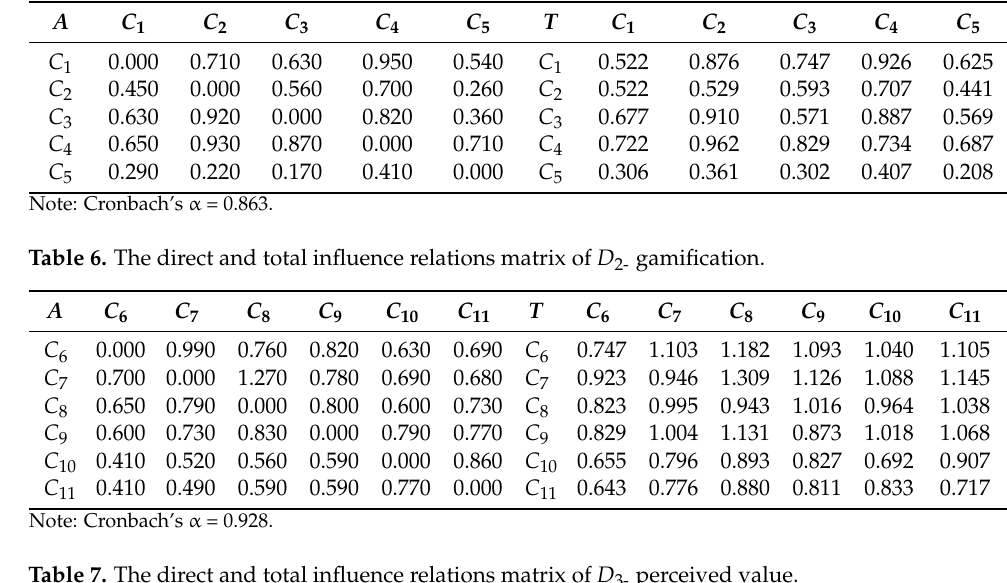
Table 7. The direct and total influence relations matrix of D 3- perceived